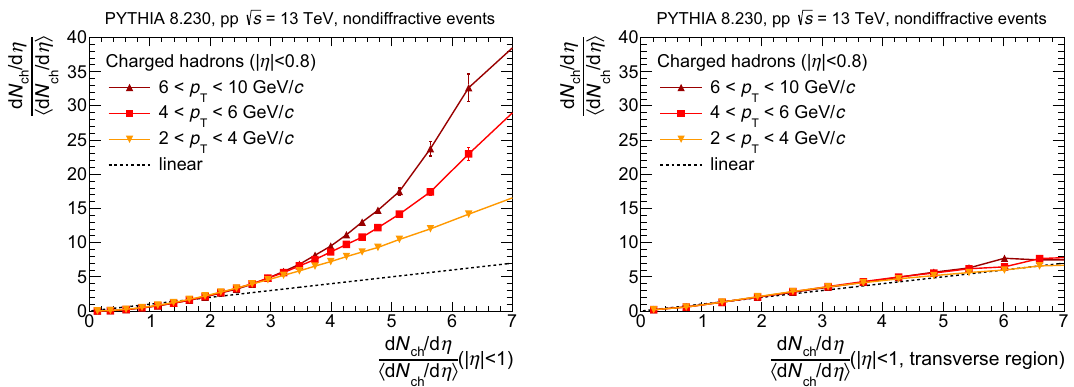
Fig. 14 Mid-rapidityhadron productionasafunctionofcharged-particlemultiplicityatmidrapidityindifferent p T intervals(left)andasafunction of the charge-particle multiplicity in the Transverse region